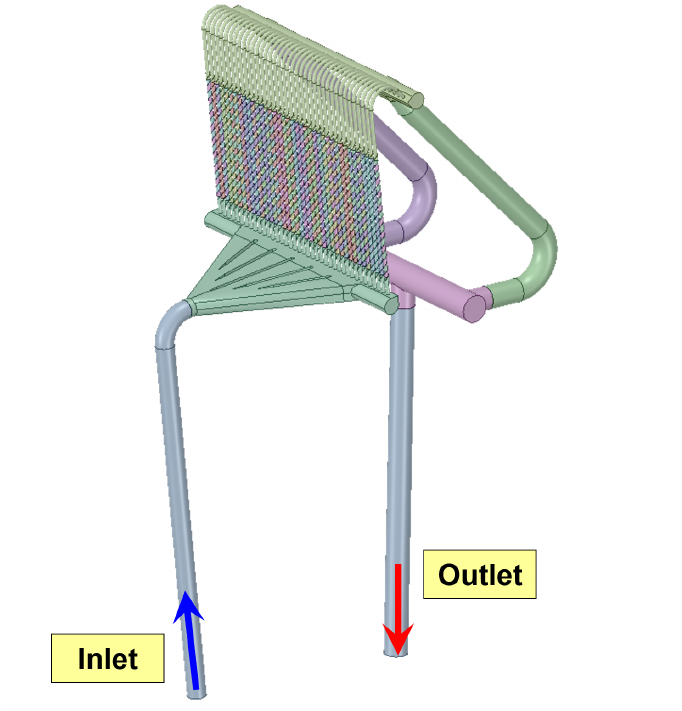
Figure 8. OVT mock-up cooling circuit calculation domain.